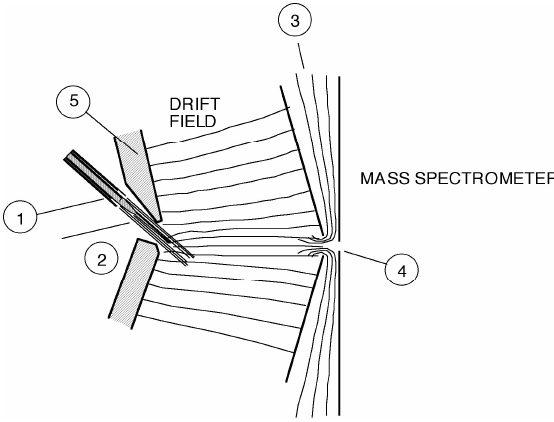
Figure 4 . Configuration implemented with an Ion Sray TM source and an API 3 plus mass spectrometer from AB-MDS